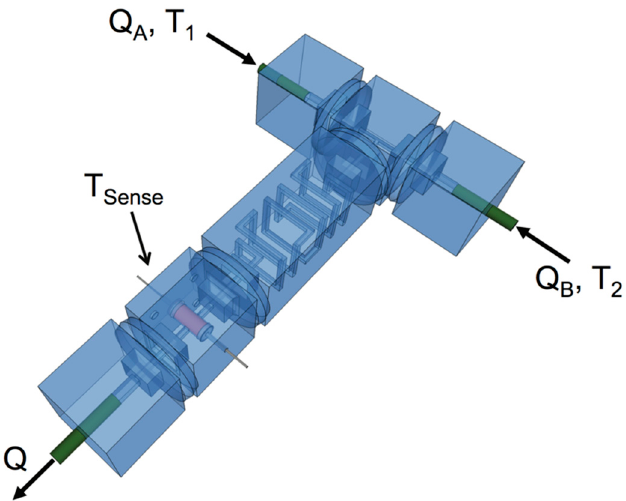
Figure 2. Microfluidic assembly composed of the discrete elements in Figure A1 used to perform the characterizations reported in this work. For each flow rate, the test device was allowed to reach steady state as judged by stability of the measured temperature. The temperature of the syringes and test device were then recorded over 30 s, approximately once a second. The resulting offset between the test device reading and average of the syringe readings was then computed.